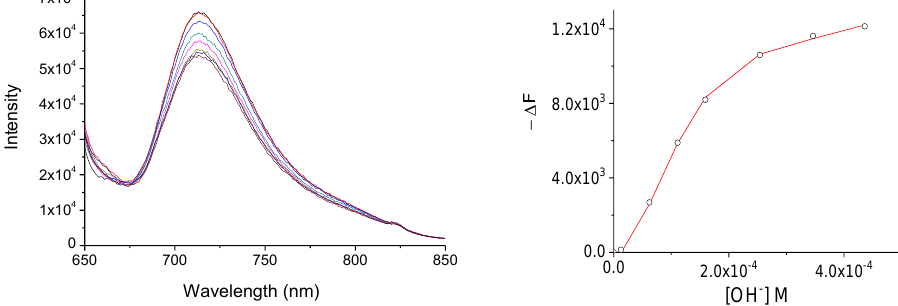
Figure 6. Fluorescence spectra of MSNP-Pc1 (2.4 × 10 −4 mol.dm −3 ) in H 2 O upon increasing concentration of OH − (7.5 × 10 −3 mol.dm −3 ) when excited at 630 nm (left); and binding profiles and the generated fit at 725 nm (right).